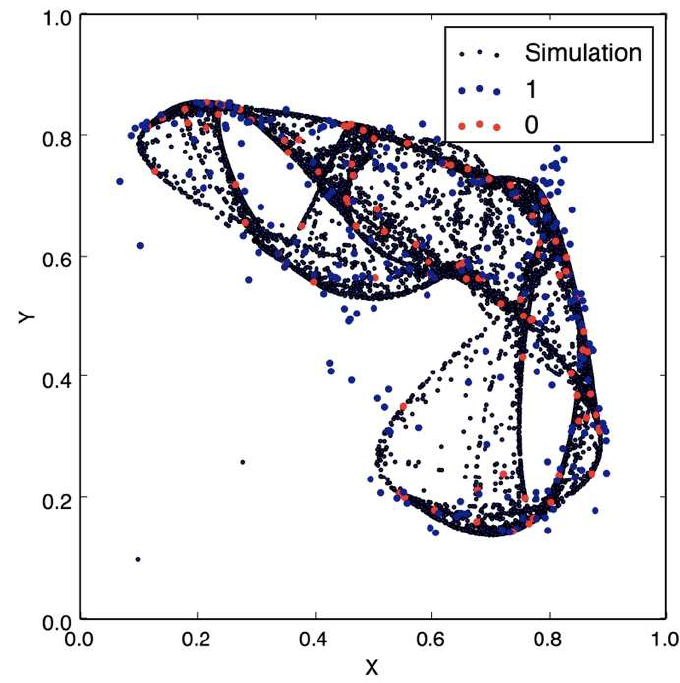
Figure 3. A message encrypted over the fully-known dynamic of Figure 1.